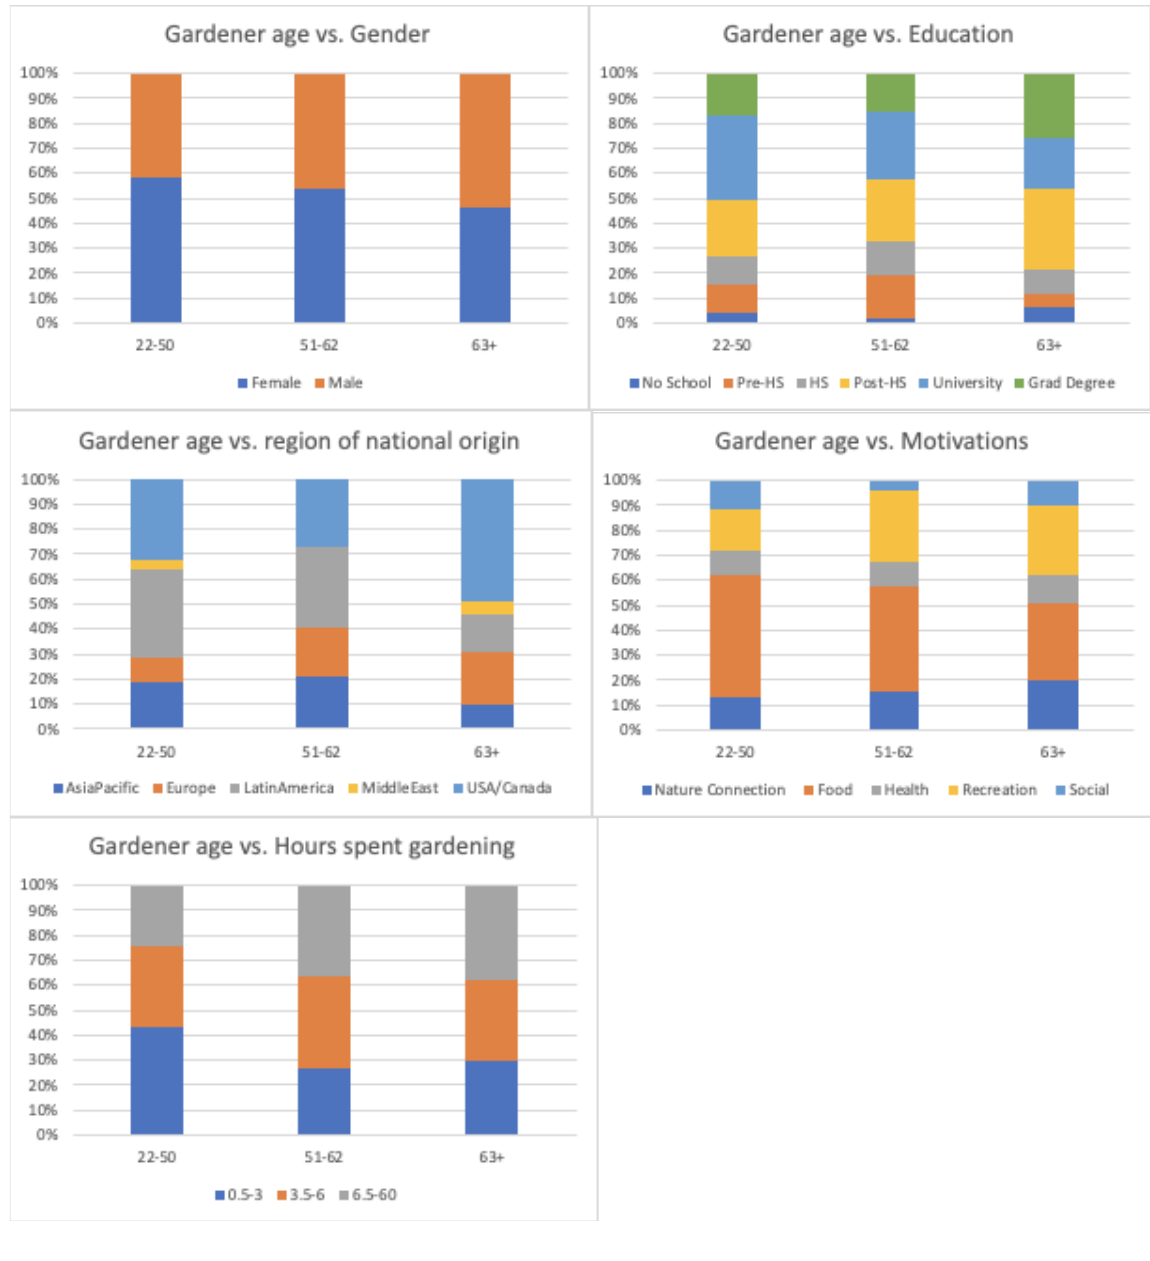
Figure A2.2. Relationships between age of gardener and gender, education, region of national origin, motivations, and hours spent